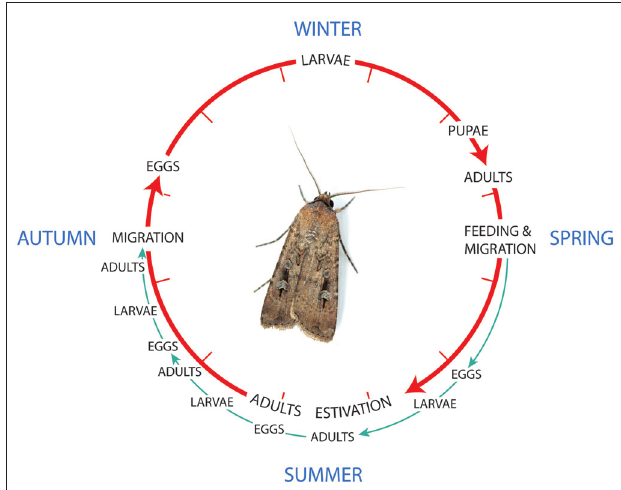
FIGURE 5 | The lifecycle of the Bogong moth, a multivoltine species with the potential for three overlapping generations in favorable conditions where there is access to larval food plants green pathway . However, in most Bogong moth breeding areas conditions do not remain favorable, and moths from such areas undergo a spring migration to escape the unsustainable conditions ( red pathway ). Re-drawn from Common (1954). Photo of the Bogong moth courtesy of Ajay Narendra, Macquarie University,